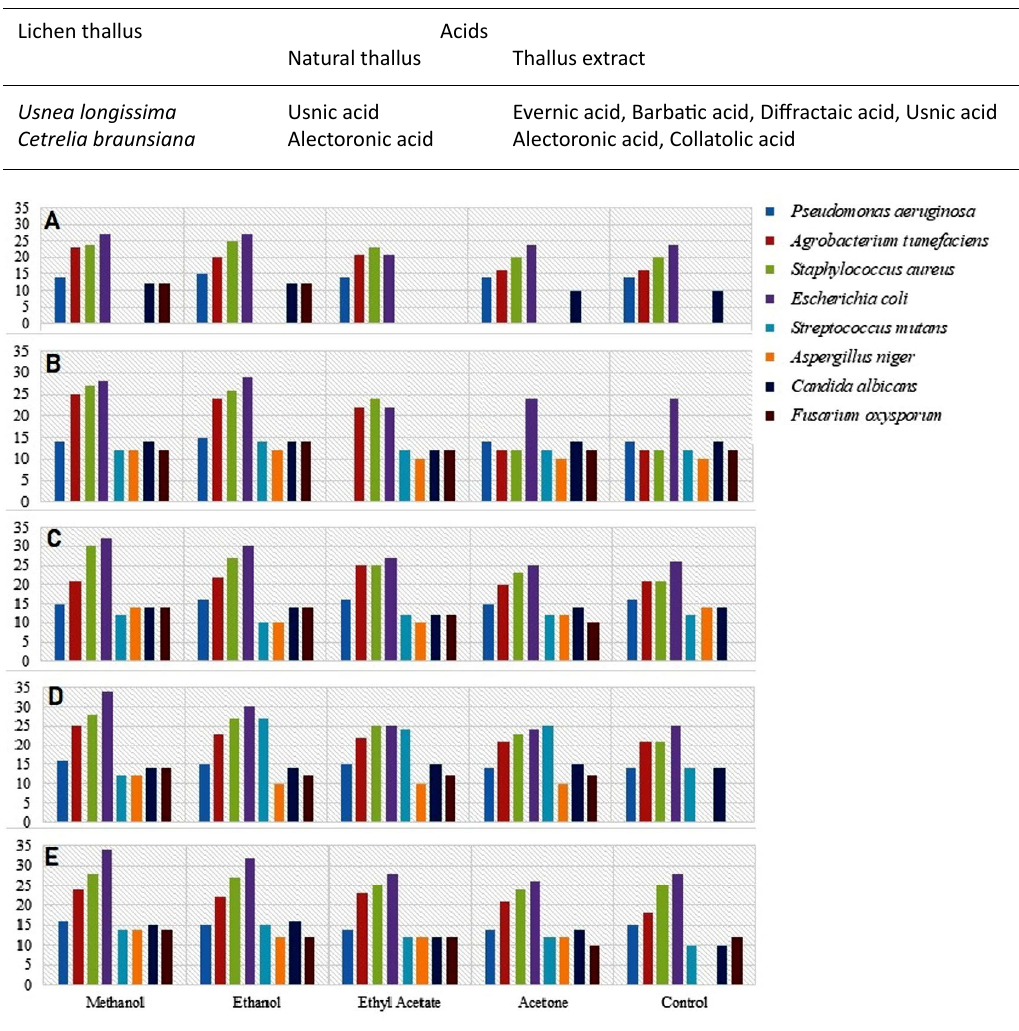
Fig. 5. Inhibitory zones recorded from the antimicrobial activity of extract from Usnea longissima : A) Inhibitory zone variations in 2.5 mg/ml extract. B) Inhibitory zone variations in 05 mg/ml extract. C) Inhibitory zone variations in 10 mg/ml extract. D) Inhibitory zone variations in 15 mg/ml extract. E) Inhibitory zone variations in 20 mg/ml